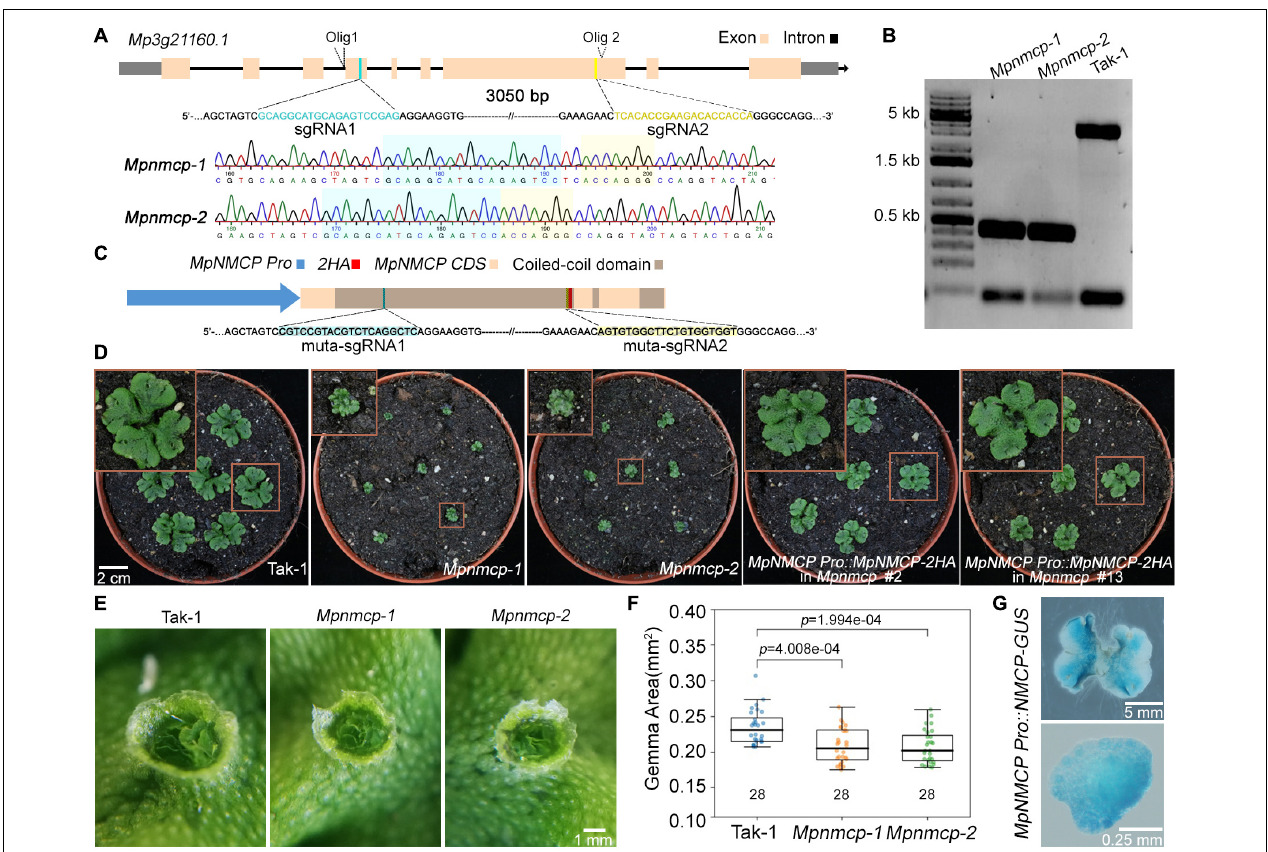
FIGURE 1 | Mpnmcp mutants show dwarf phenotype. (A) Schematic depiction of the MpNMCP locus and single-guide RNAs (sgRNAs) aiming for site-directed mutagenesis (top). Representative sequencing tracks of using Olig1 ( Supplementary Table 2 ) showing the deletion of a ∼ 3-kb region flanked by the two sgRNAs (middle and bottom). (B) Genotyping PCR results of individual T3 Mpnmcp mutants. Genotyping was carried out by using genotype specific primers: Olig1 (forward primer) and Olig2 (reverse primer) (primer sequences are given in Supplementary Table 2 ). (C) Schematic depiction of the MpNMCP CDS with MpNMCP promoter (2-kb upstream of the gene model). HA, hemagglutinin tag. muta-sgRNA1 and muta-sgRNA2 indicate the two regions to which silent mutations are introduced to avoid recognition by the sgRNAs used for site-directed mutagenesis of the endogenous MpNMCP locus. (D) Phenotype of 3-week-old wild-type (WT) Tak-1, Mpnmcp mutants, and two independent MpNMCP Pro:MpNMCP-2HA/Mpnmcp transgenic lines. The MpNMCP Pro:MpNMCP-2HA in the Mpnmcp mutant displayed normal development. (E) Close-up of one gemma cup from 20-day-old WT Tak-1 or Mpnmcp mutants, which have mature gemmae inside. (F) Boxplot shows the size of gemmae collected from gemma cups of Mpnmcp mutants and Tak-1 plants. n = 28. p values were determined by Mann–Whitney U test. (G) Glucuronidase (GUS) staining of MpNMCP Pro:GUS plants. Pictures show the representative distribution pattern of GUS staining in 2-week-old thallus (top panel, scale bar = 5 mm) and gemmae (bottom panel, scale bar = 0.25